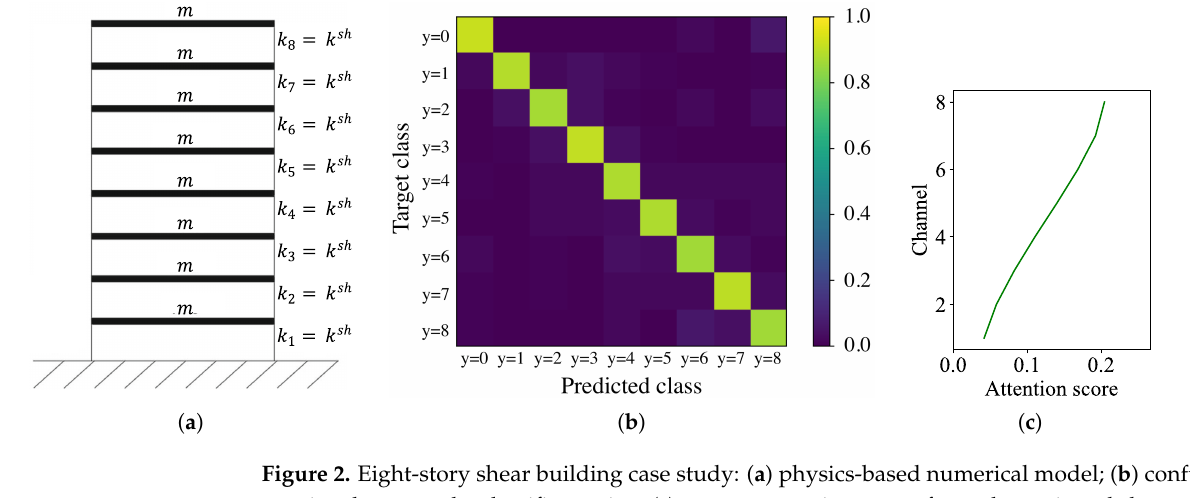
Example 2: shear building model with constant story mass and story sti ↵ ness. Adapted from [45] Figure 6.1: Figure 6.12: Example 2A: means of the attention scores computed across the test set for each channel. Figure 2. Eight-story shear building case study: ( a ) physics-based numerical model; ( b ) confusion matrix relevant to the classifier testing; ( c ) average attention scores for each monitored response of the model is advanced in time using the Newmark time-integration scheme explained 1 . in Chapter